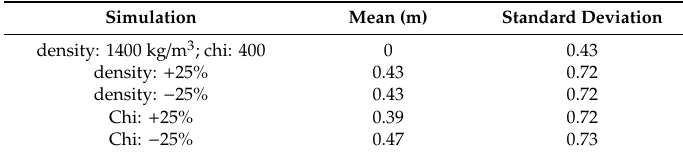
Figure 6. Absolute deviation (in m) of PSI as observed on the trunks of Pinus hartwegii trees in a sector of Jamapa Gorge and their relationship with ( A ) lahar depth, ( B ) flow velocity, and ( C ) pressures modeled for the 2012 lahar. ( D ) The hydrograph data correspond to the 2001 lahar in Popocatépetl volcano by Caballero and Capra [36]. The dashed black line represents the assumed shape of the hydrograph used in this study. Table 1. Sensitivity analysis of lahar modelling.